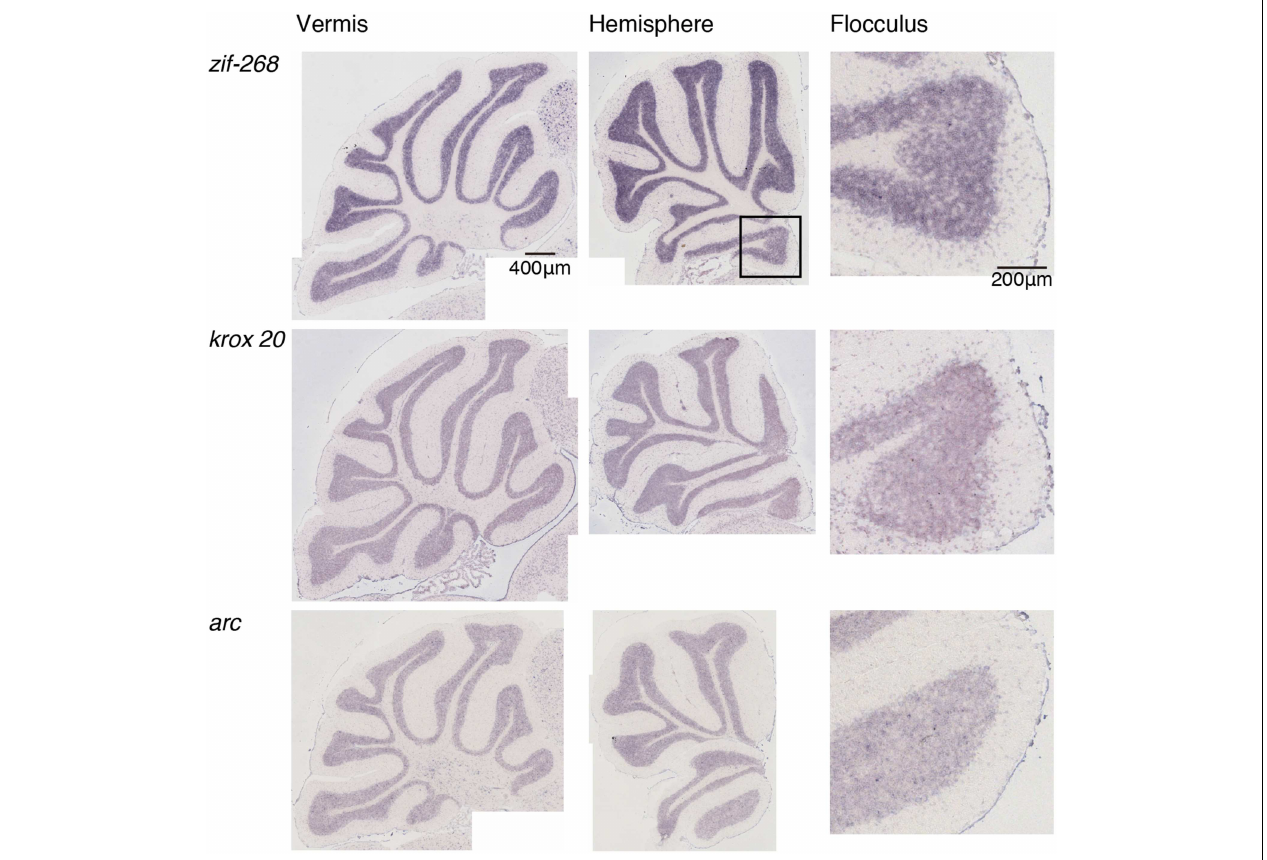
FIGURE 2 | Expression patterns of eight IEGs in the cerebellum of naive mice. Vermis ( left panel ), hemisphere ( middle panel ), and the magnified image within the box in the middle panel showing flocculus ( right panel ). Each row shows expression patterns of eight IEGs (from top to bottom: zif-268, krox 20, arc